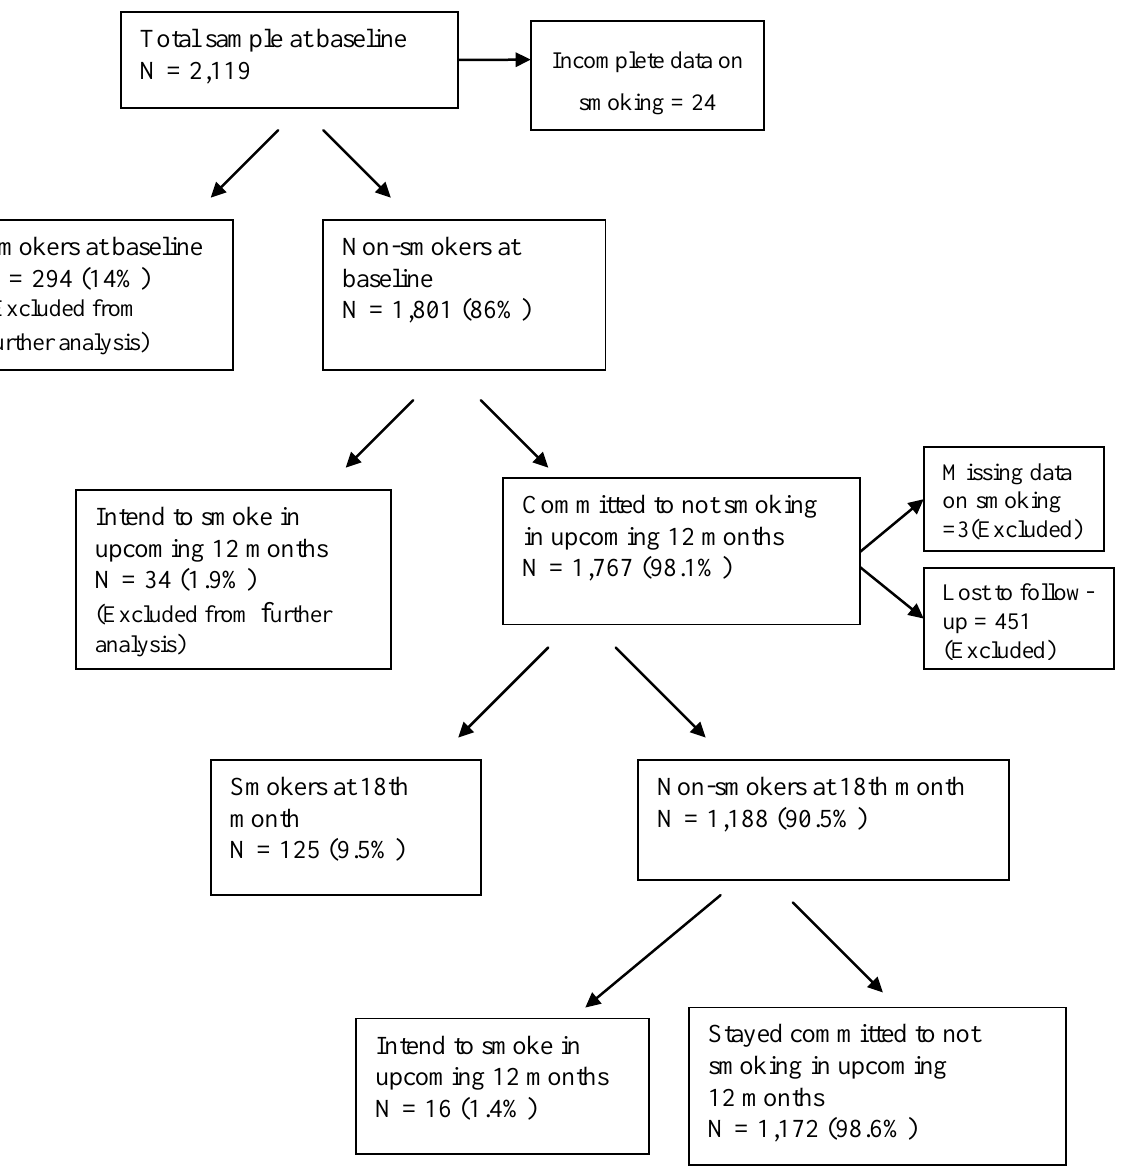
Figure 1. Classification of study participants into smokers, non-smokers, those intending to smoke and those not intending to